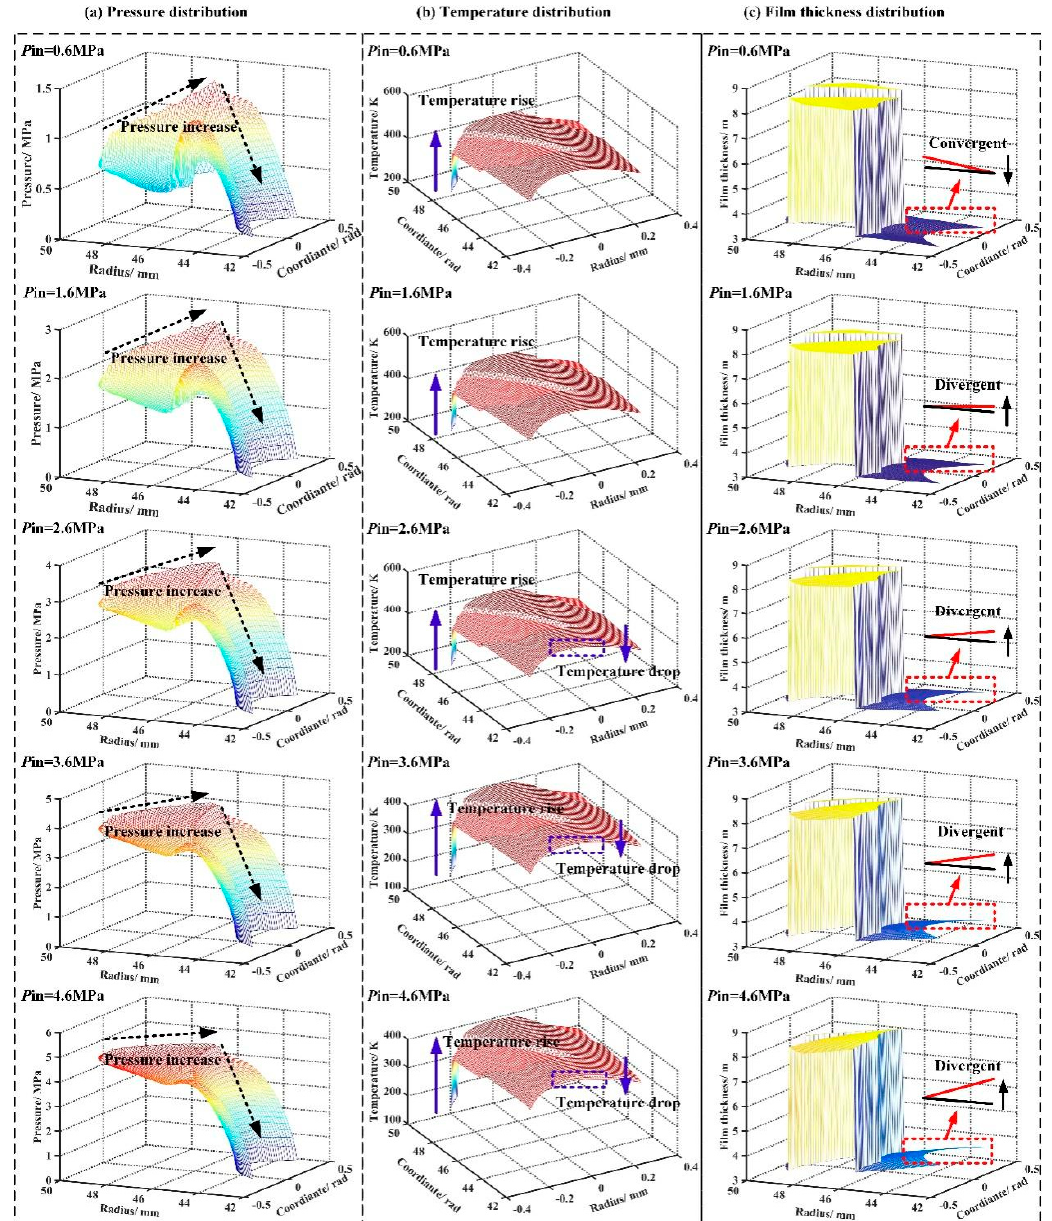
Figure 5. Distributions of the pressure, temperature, and film thickness with respect to the sealing pressure. ( P out = 0.1 MPa, T in = 200 K, T out = 350 K, n = 50,000 rpm, h 0 = 3 μ m).